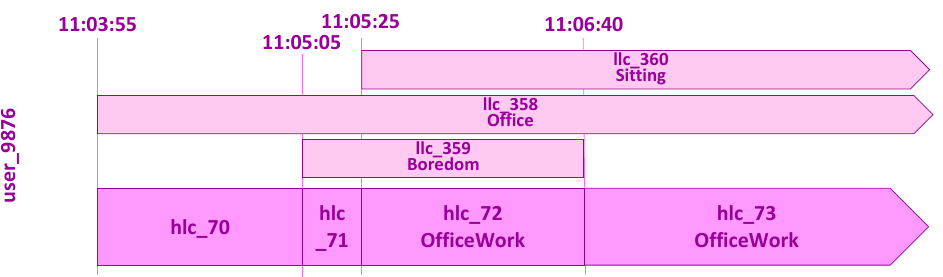
Figure 4. Exemplary scenario representing low-level contexts and high-level